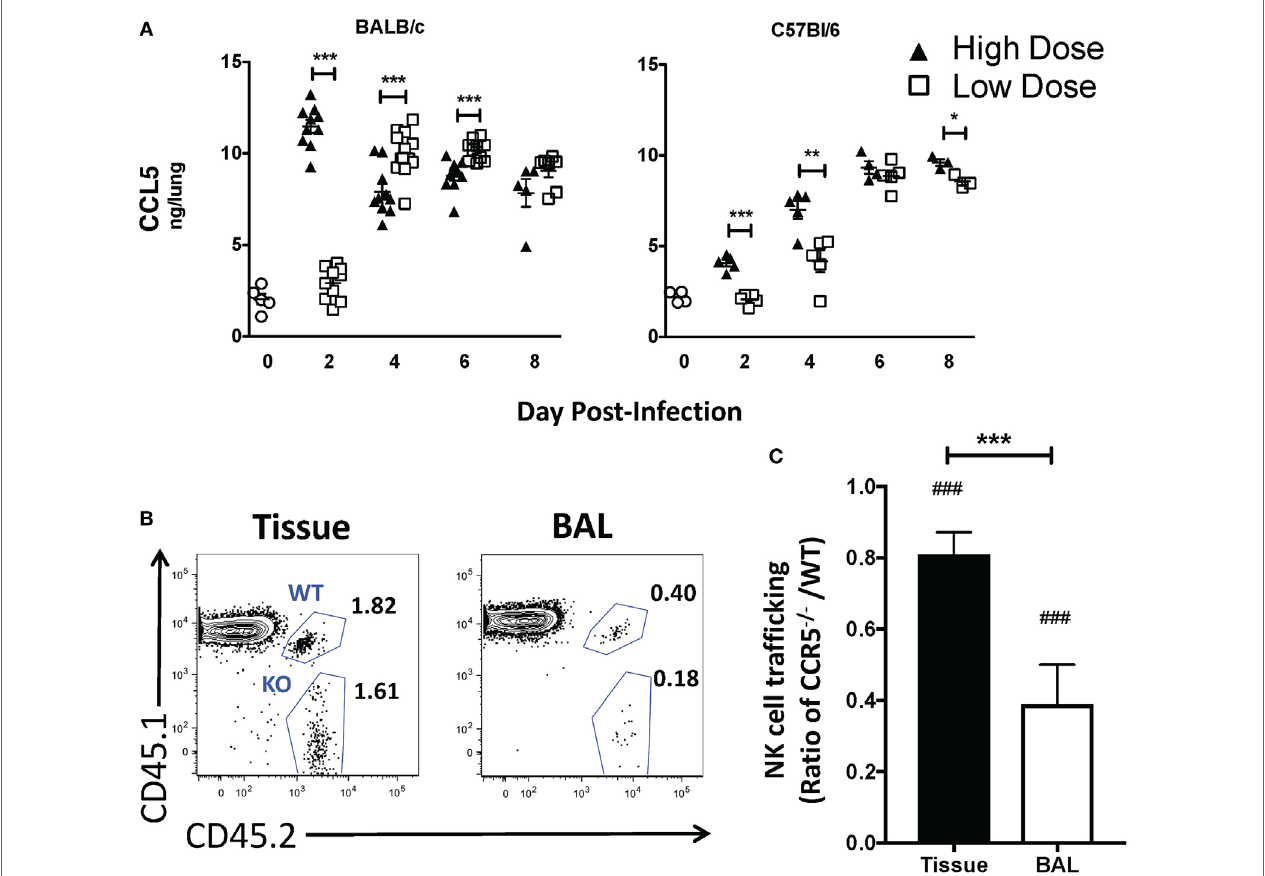
FigUre 7 | CCL5 is upregulated in the lungs during high- and low-dose influenza A virus (IAV) infections. (a) BALB/c (left) and C57Bl/6 (right) mice were infected with high- and low-dose A/PR/8/34. Lungs were harvested at indicated time points, and CCL5 in supernatants was quantified by ELISA. Uninfected mice were used as naïve controls. p -values comparing CCL5 levels in high- vs. low-dose IAV-infected mice are shown. Data were obtained from samples as in Figure 6 . (B,c) C57Bl/6 (CD45.1) host mice were infected with a high dose of IAV. 3 × 10 5 donor WT C57Bl/6 (CD45.1/CD45.2) and 3 × 10 5 CCR5 − / − (CD45.2) natural killer (NK) cells were transferred into infected host mice for 16–18 h before analysis. (B) Representative flow plots for NK cells (NK1.1 + CD3 ε − ) in the bronchoalveolar lavage (BAL) vs. lung tissue showing host (CD45.1 + CD45.2 − ), WT donor (CD45.1 + CD45.2 + ), and CCR5 − / − donor (CD45.1 − CD45.2 + ) NK cells. (c) Shown is the normalized ratio of CCR5 − / − NK cells to WT NK cells in the lungs or BAL fluid of infected recipients. Data are from one experiment with six mice per group. Note: equal trafficking between WT and CCR5 − / − NK cells = 1. p -values comparing WT to CCR5 − / − NK cell trafficking (two-tailed paired Student’s t -test) within the same group are shown. ### p < 0.001 and comparing the ratio of CCR5 − / − /WT NK cell trafficking in the BAL vs. lung tissue. *** p <